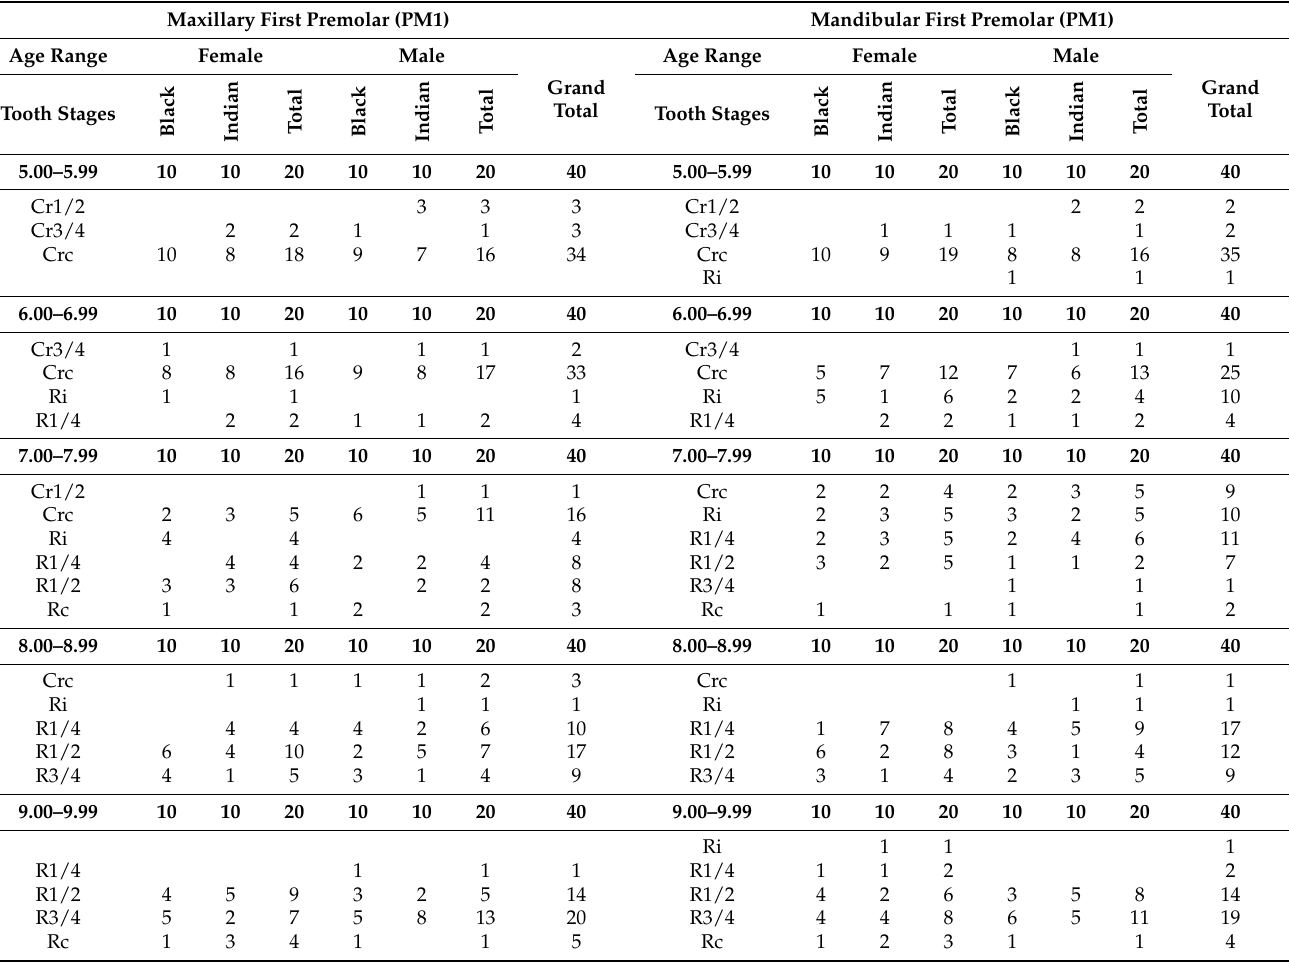
Table A4. Frequencies of the tooth development stages of the first premolar for the SA Black and Indian population